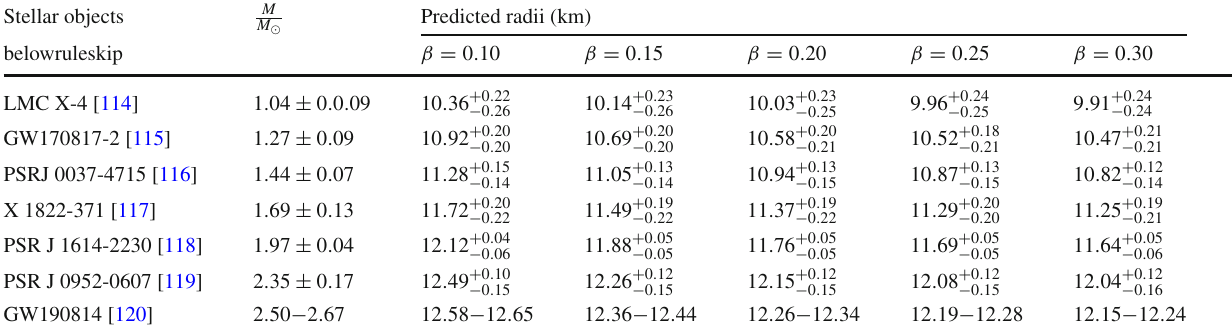
Table 1 Numerical values of the predicted radii of different stars for Solution 5.1 with surface density ρ s (cid:12) 6 × 10 14 gm / cm 3 , A = 0 . 0078 , B = 0 . 0093 ,α = 1 . 2